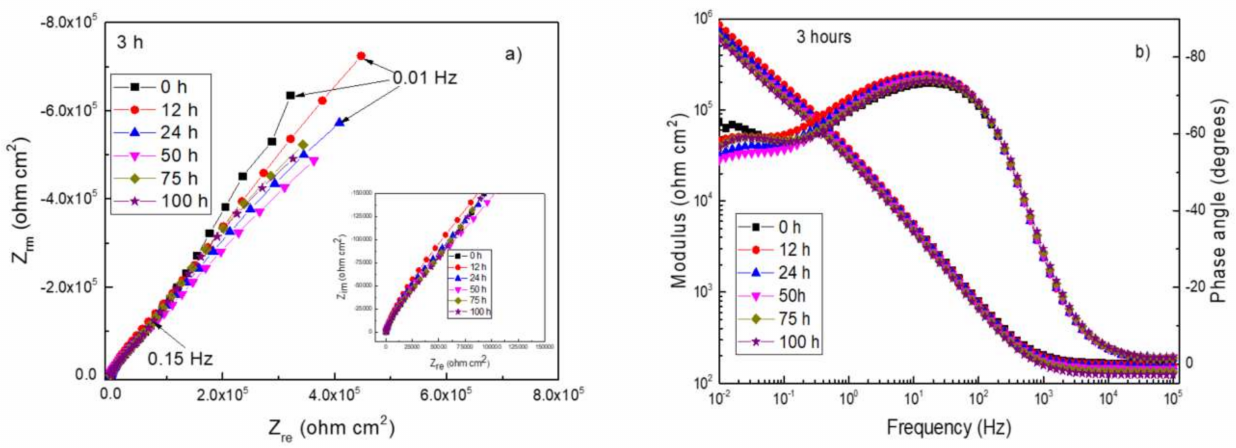
Figure 8. EIS data in ( a ) Nyquist and ( b ) Bode diagrams for Ti6Al4V alloy oxidized during 3 h and corroded in artificial saliva solution after different exposure